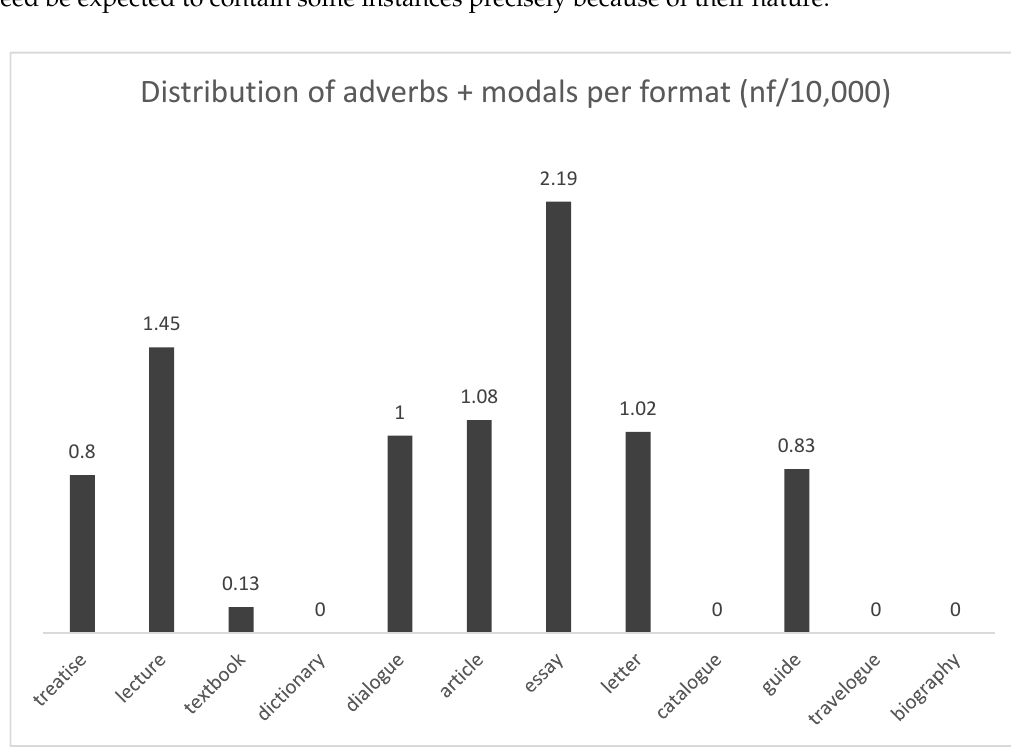
Figure 7. Use of possibly with modals per communicative format.